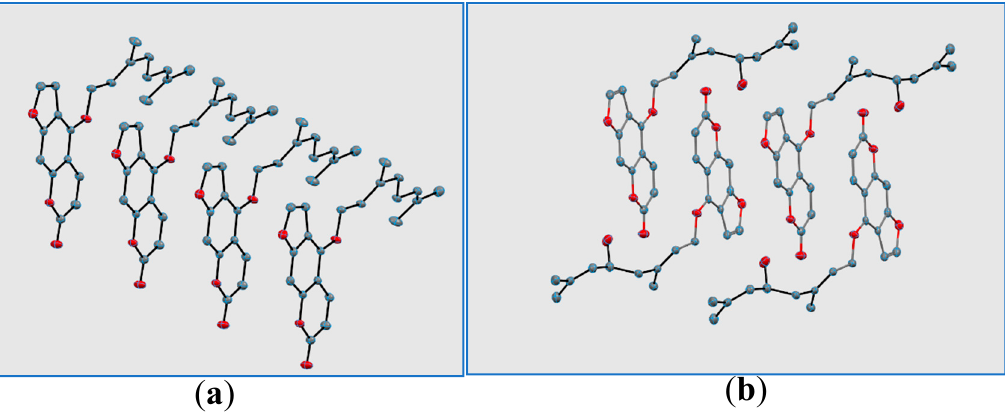
Figure 17. Crystal structure packing, hydrogen atoms omitted. ( a ) Bergamottin (this work); ( b ) Notopterol (CSD-SOLXUN) [22].